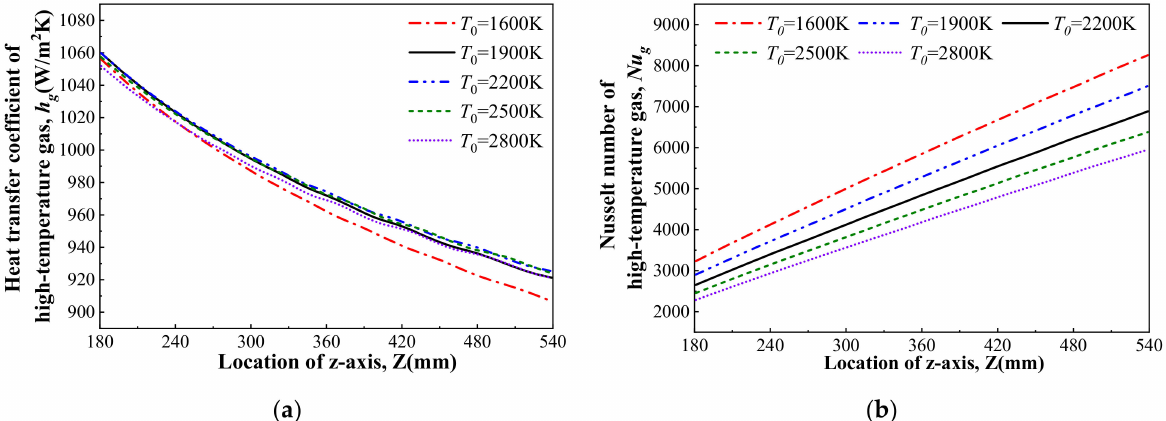
Figure 18. Variation of h g and Nu g with total temperatures of gas ( a ) h g ( b ) Nu g